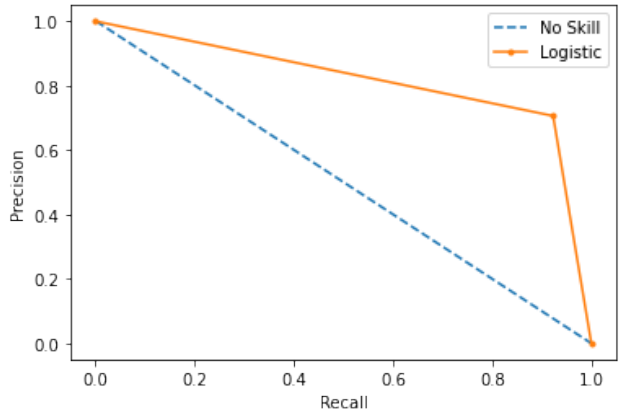
Figure 7. Precision of RF.